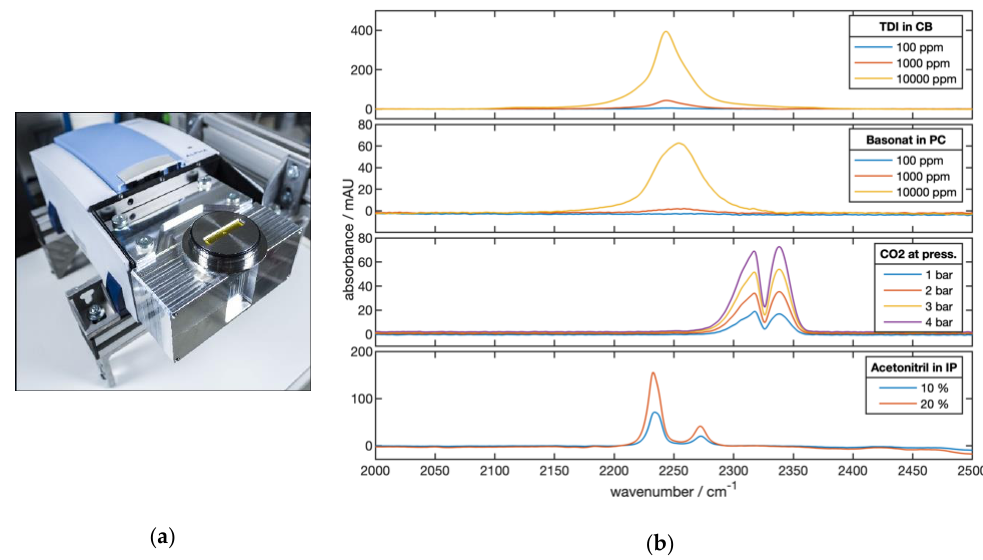
Figure 3. ( a ) Planar ATR element with Varivent flange coupled to a Bruker Alpha FTIR instrument. The system can be attached to a liquid or gas flow system capable for pressure levels of up 5 bar. ( b ) Measured ATR spectra of TDI in MCB, Basonat in propylene carbonate (PC), gaseous CO 2 , and acetonitrile in isopropanol (IP). Table 2. Peak absorbances of sample spectra from Figure 3b. Values for the second maxima are in brackets. The relative absorption strength is calculated for the main peaks.